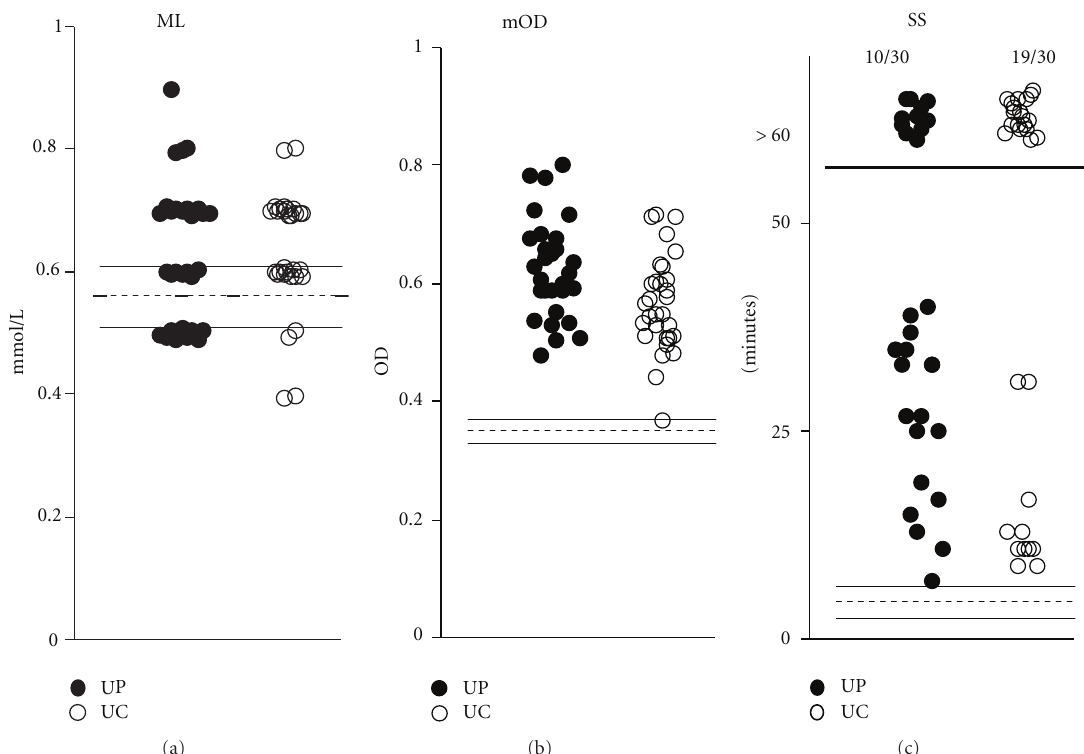
Figure 2: Crystallization parameters in urine of stone patients (UPs) and of controls (UCs) and in control solution (shaded area, mean ± SD): ML (metastable limit = Ox addition necessary to induce crystallization), mOD (maximal optical density reached at the end of Ox titration), and SS (suspension stability = time after titration without